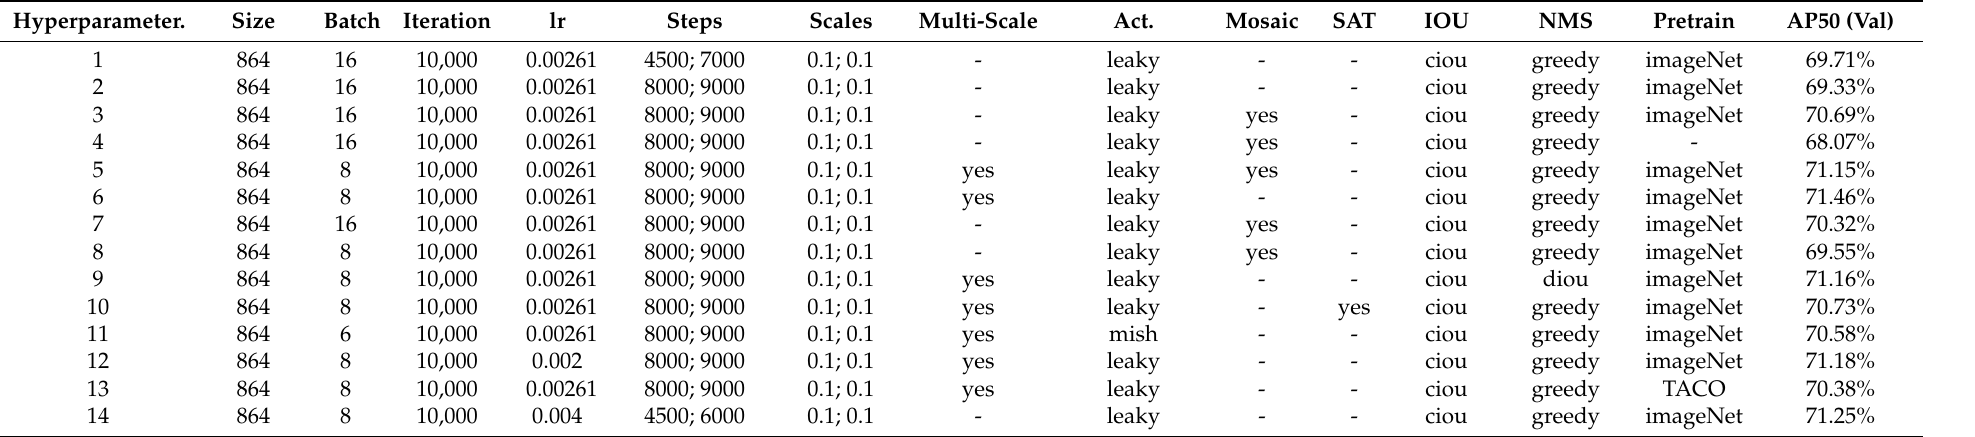
Table 3. Hyperparameter sets for the YOLOv4-Tiny-3l model